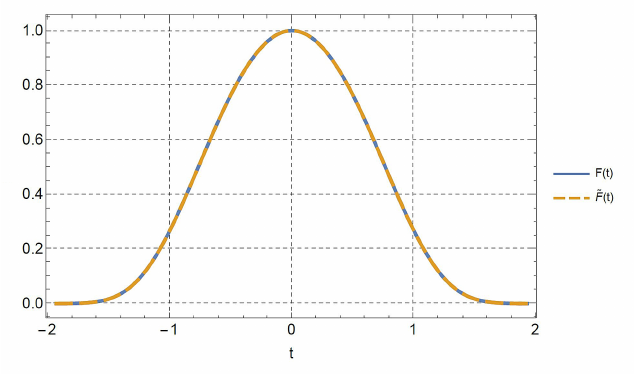
√ Figure 4. Graph of the function F ( t ) = exp [ − ( t + t 3 /4 3 + t 5 /240 ) 2 ] . The percentage deviation between F ( t ) and the relevant expansion ˜ F ( t ) in terms of Bell’s polynomials is shown in Figure 5. As can be seen, F ( t ) is nicely approximated by ˜ F ( t ) in the domain where F ( t ) does not assume negligibly small values.